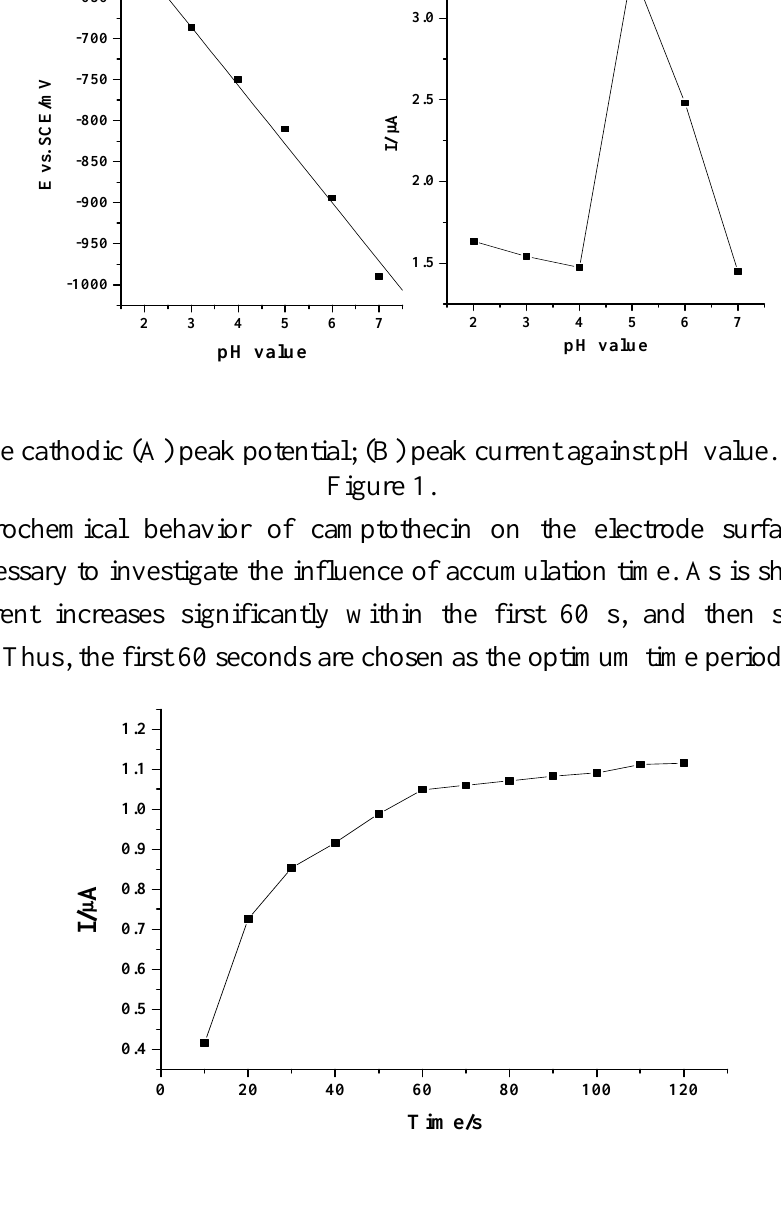
Figure 4. Dependence of the cathodic peak current on the accumulation time. Others same as in Figure